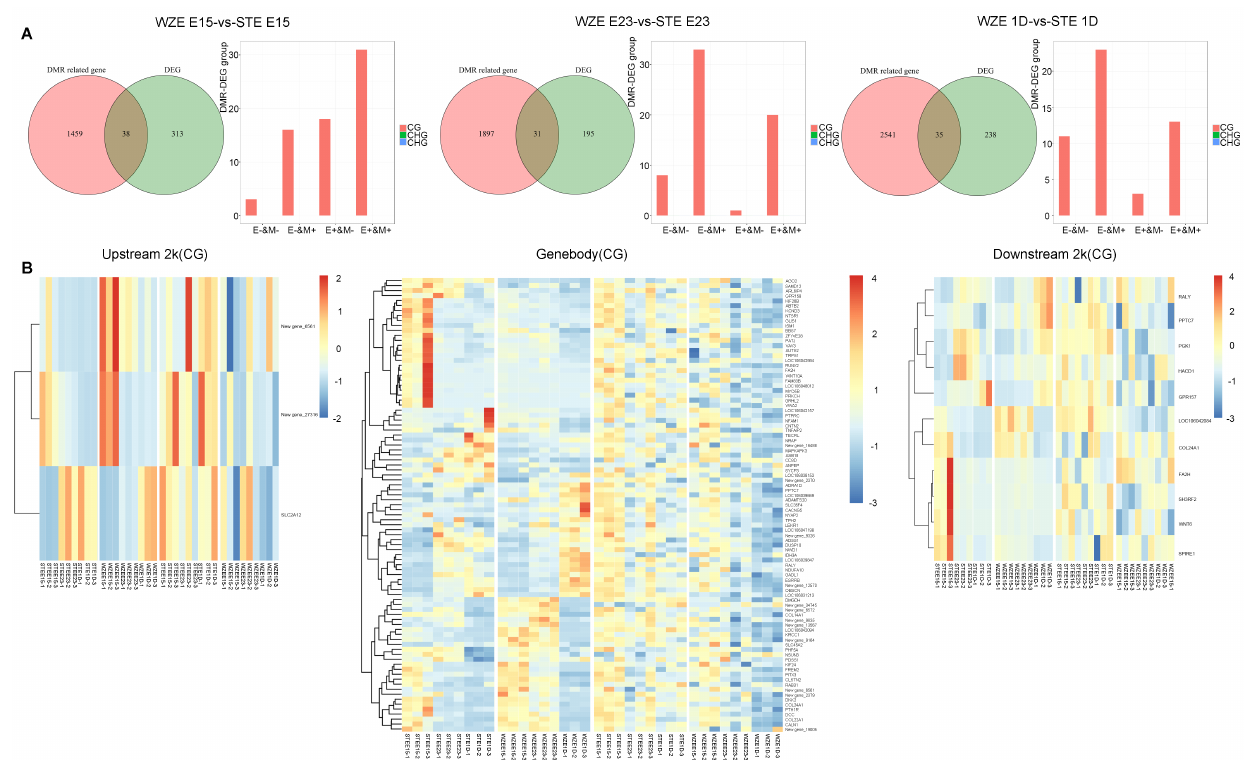
Figure 4. The identification of differentially expressed genes (DEGs) regulated by DNA methylation during embryonic development. ( A ) Venn diagram of DMR related genes and DEGs at the same stage between two goose breeds, together with statistical results of genes involved in different modes of DNA methylation and gene expression correlation. ( B ) Heatmap of gene expression patterns of genes that were both DMR − related genes and DEGs in upstream 2 kb, gene body, and downstream 2 kb regions (hierarchical cluster analysis on the left panel and non-hierarchical cluster analysis on the right panel). E, gene expression level; M, DNA methylation level; +, upregulation; − ,